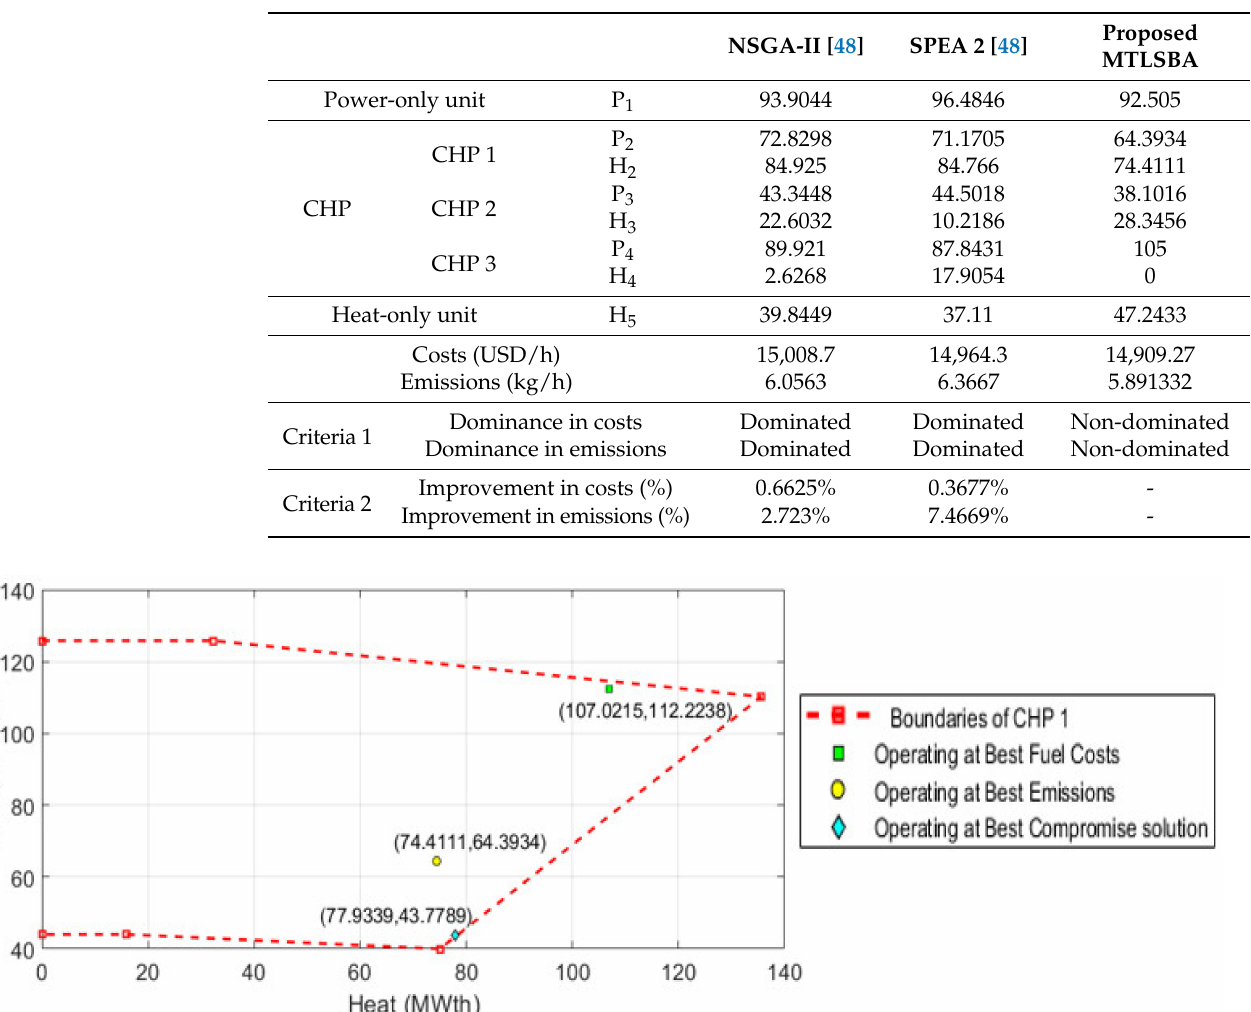
Table 3. Best compromise results of test system 1 using the proposed MTLSBA.